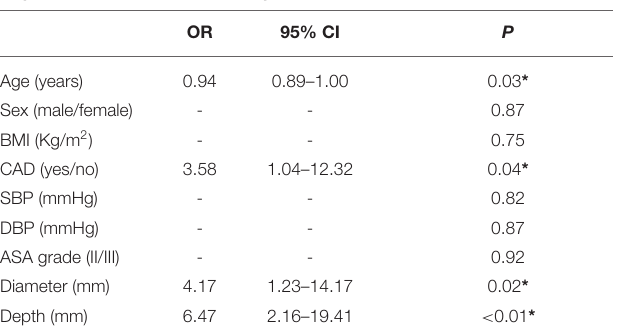
TABLE 2 | Factors associated with the first-attempt success of DNTP guided RAC with multiple logistic regression analysis. Dependent variable = first-attempt success catheterization or not